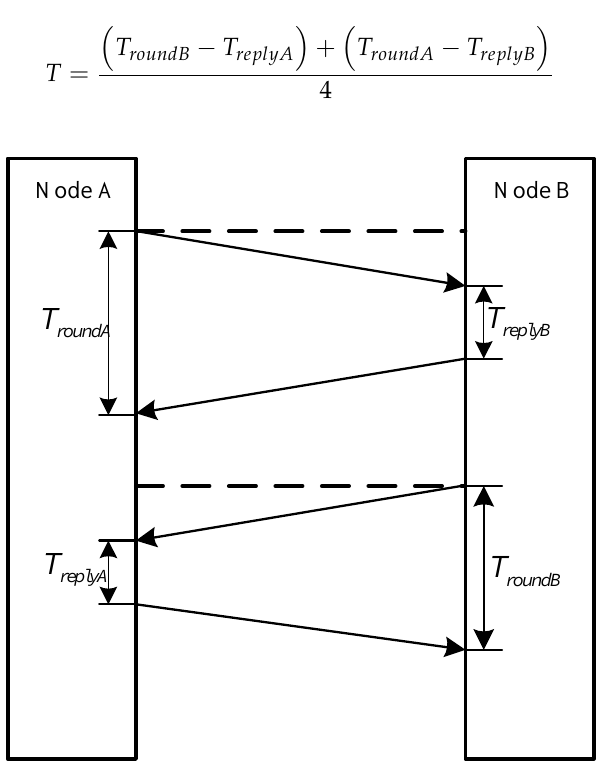
Figure 20. The progress of measuring for CSS localization system.